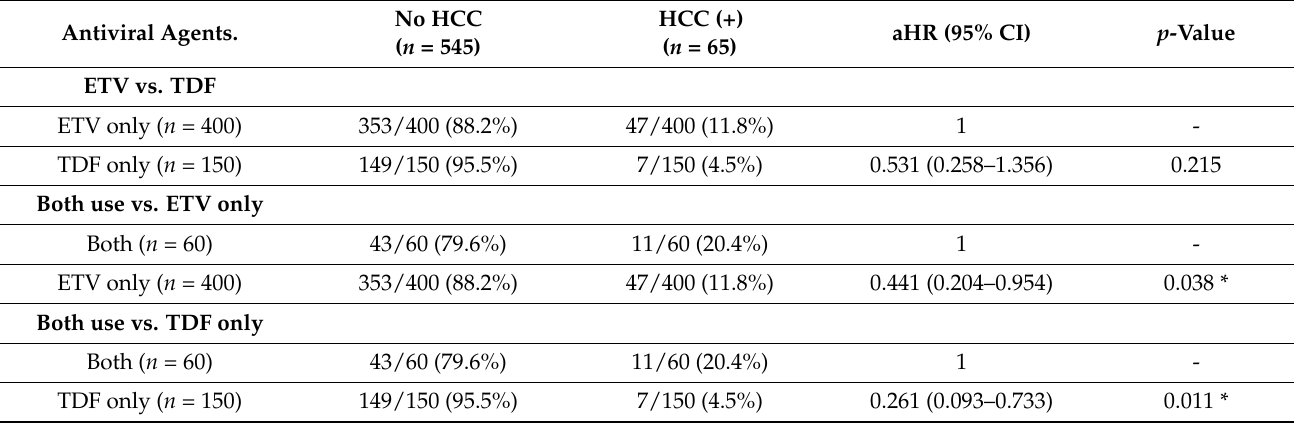
Table 3. HCC risk in a multivariate time-dependent Cox regression analysis according to antiviral agents use. Antiviral